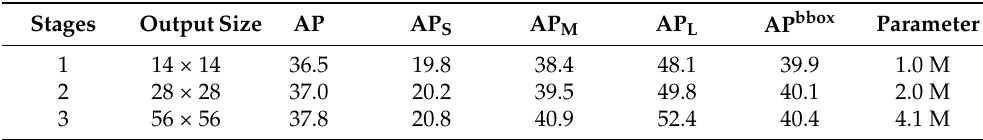
Table 3. The effectiveness of the multistage head. The FCN mask head in Mask R-CNN was replaced with a multistage fusion mask head, and detailed experiments were performed for each